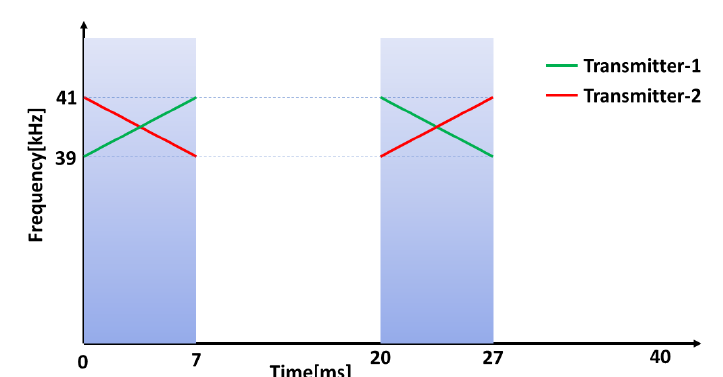
Figure 7. Representation of signals transmitted in one sampling instance of 40